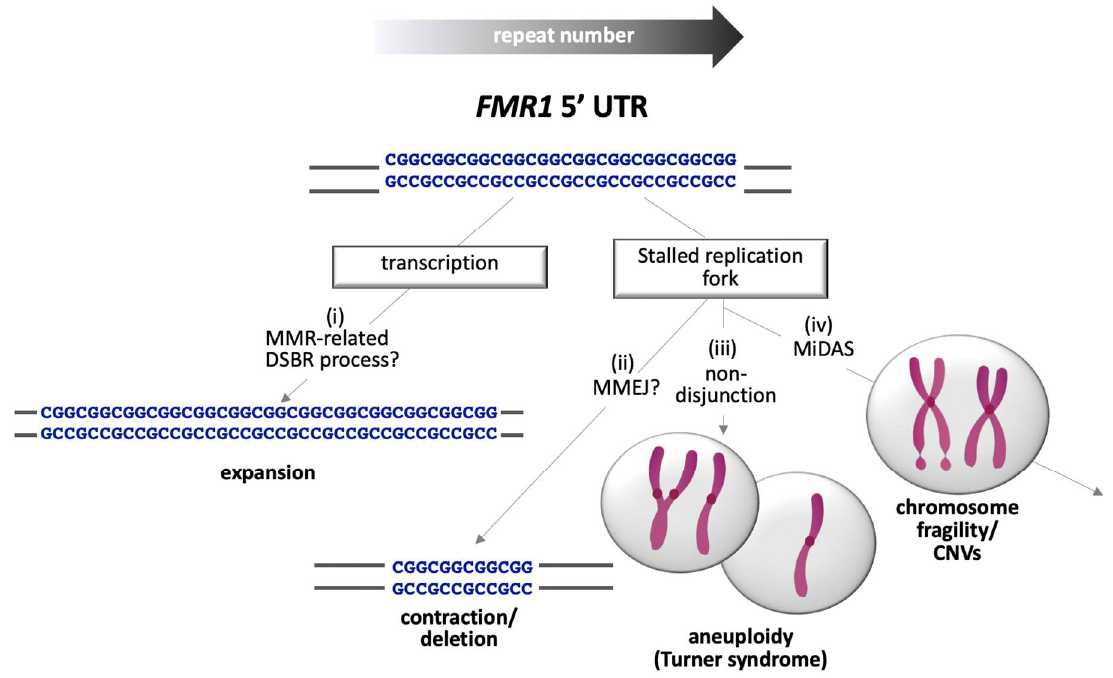
Figure 4. Summary of potential sources of genomic instability associated with PM and FM alleles. Transcription of long CGG-repeat tracts promotes a form of MMR-dependent DSBR that leads to expansion (i). As the repeat number increases, the incidence of replication fork stalling increases. Repair of the stalled fork can lead to contractions or deletions (ii). Aneuploidy can result when stalled forks are not repaired (iii), while chromosome fragility results when repair of the stalled forks by MiDAS is incomplete (iv).